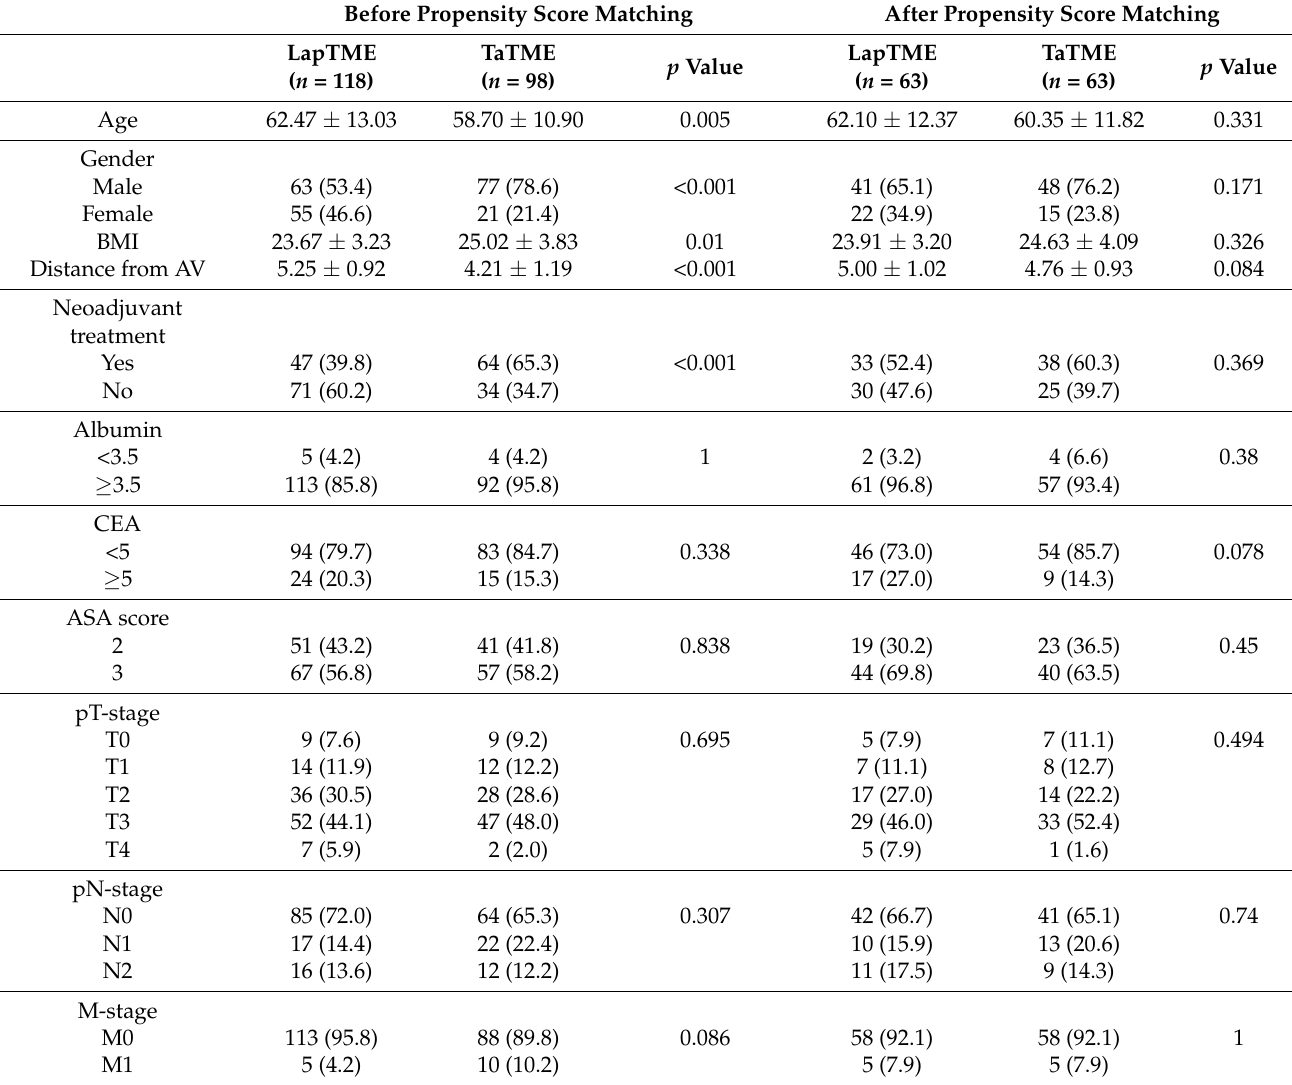
Table 1. Basic characteristics of patients with low rectal cancer who underwent restorative proctec- tomy before and after propensity score